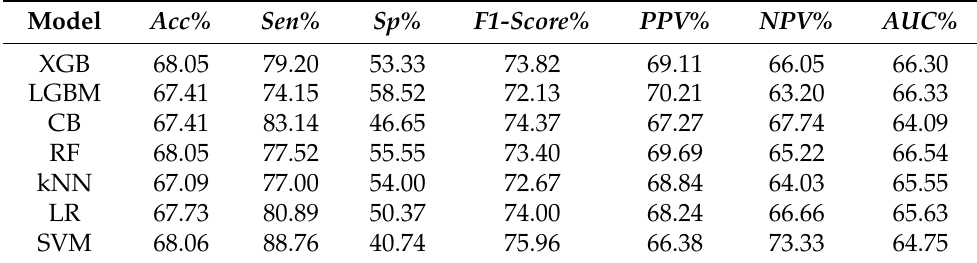
Table 1. Classification performance measures across ensemble and traditional models for 8 EHR features.